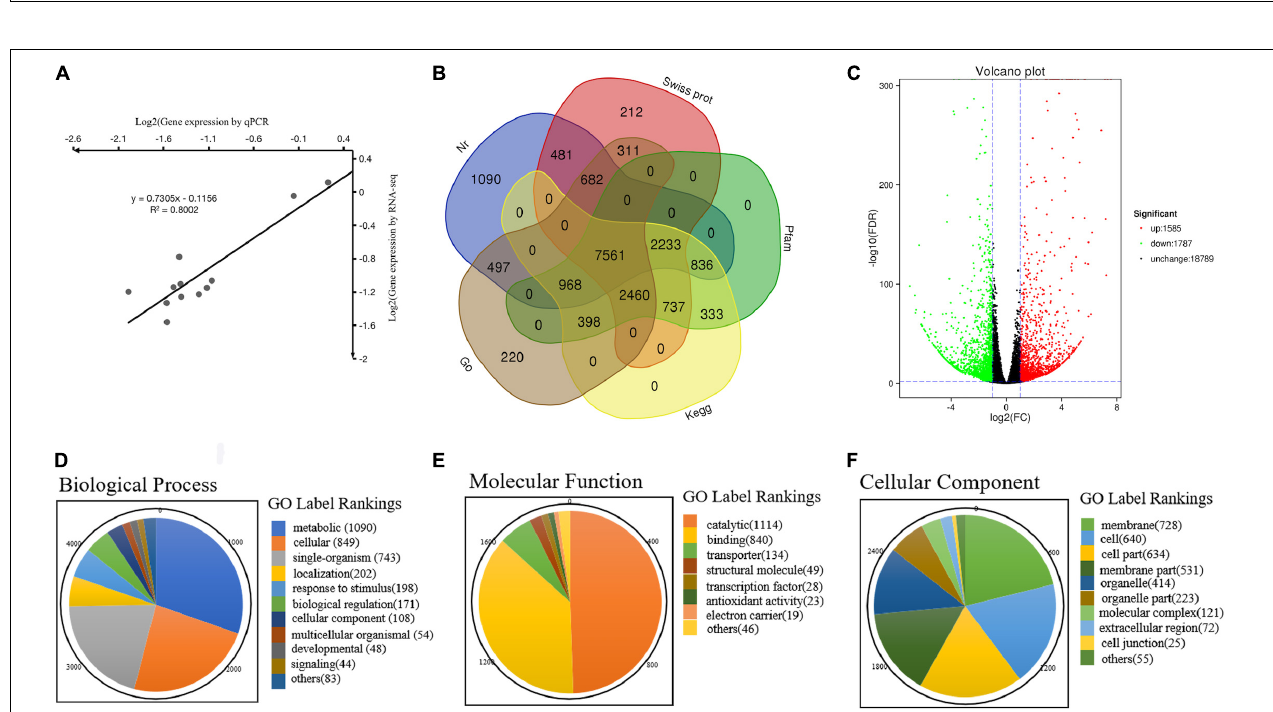
FIGURE 1 | Phenotype and leaf epidermis ultrastructures of wild type (WT) and yellow-green leaf ( yl ) mutant. Panels (A–C) present WTs. Panels (D–F) present yl mutants. Panel (A) is Rosa beggeriana , used as WT. Panel (D) is the yl mutant. Panels (B,E) are leaf lower epidermis in bar with 100 µ m. Panels (C,D) are leaf stomata in bar with 10 µ m.